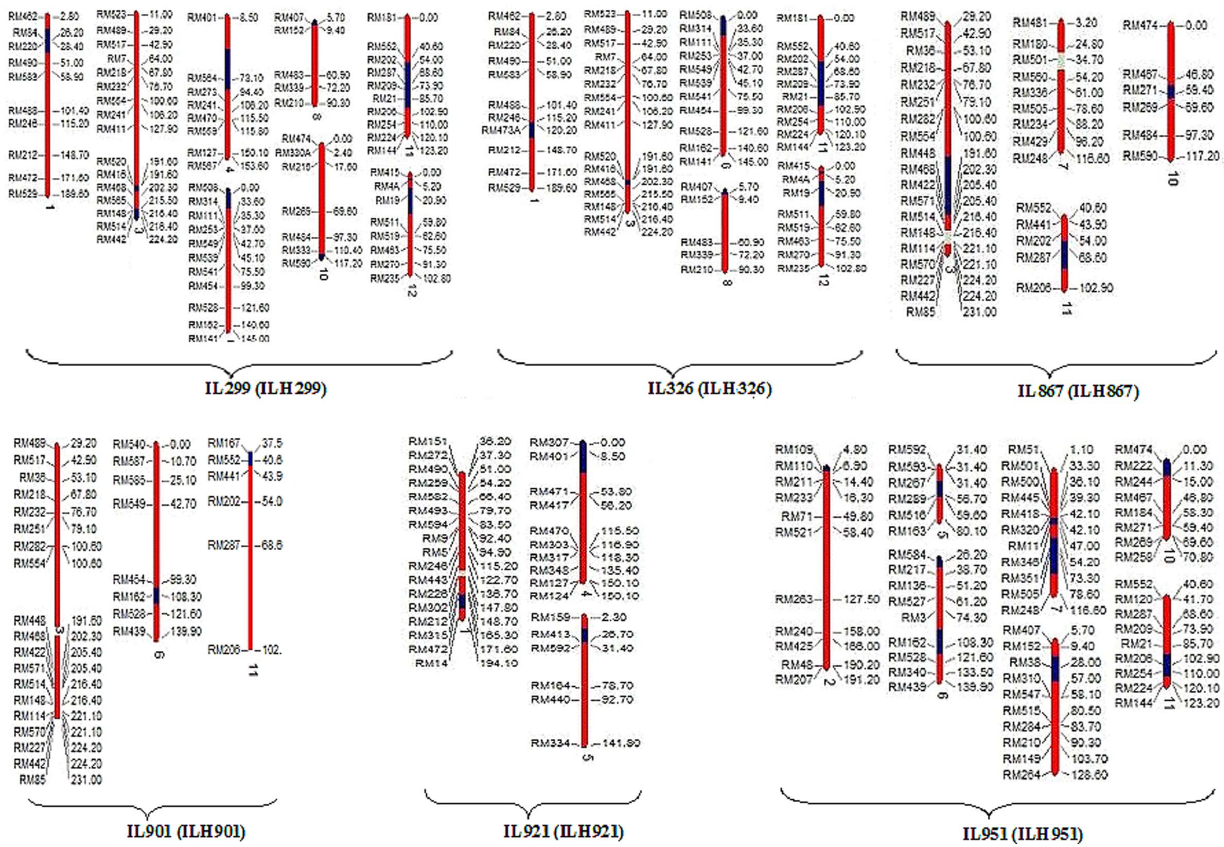
Figure 4. Graphical genotypes of six alien introgression lines generated after analyzing these with polymorphic SSR markers. Regions in blue are homozygous alien segments and gray are heterozygous alien segments introgressed from O. rufipogon in IL299, IL326, IL867 and IL901 and O. nivara in IL901 and IL951. Numbers on the right of linkage group are the cM distances as per Temnykh et al [32]. Numbers at the bottom are the chromosomes. Details of the ILHs in parentheses are presented in Table 1.